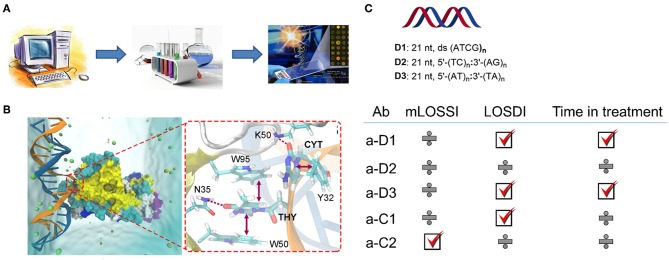
Synthetic DNA, RNA, and LNA antigens in morphea (56). (A) A general approach to the design including computation, library screening, and ELISA; (B) representative molecular dynamics result for dsDNA antigen and autoantibody showing key interactions contributing to the binding; (C) Representative antigens selected for the study of the pediatric morphea cohort, and correlations of ELISA results with modified localized scleroderma skin severity index (mLOSSI), index of disease damage (LOSDI), and time in treatment. C1 and C2 were commercial controls used in the study, calf thymus DNA, and G-quadruplex human DNA.